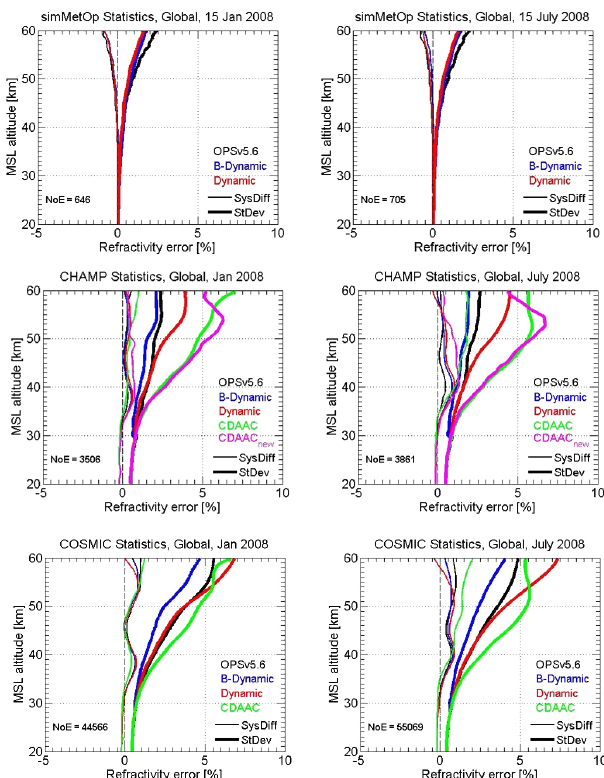
Figure 13. Systematic differences (SysDiff, light lines) and stan- dard deviations (SD, heavy lines) of retrieved refractivity profiles, relative to “perfect” simulated refractivity or co-located ECMWF analysis refractivity used as a reference, for the global ensemble of simMetOp events on 15 January and 15 July 2008 (top panels) and of CHAMP events (middle panels) and COSMIC events (bot- tom panels) from the complete months of January and July 2008. Statistics of the OPSv5.6 (black), b-dynamic (blue), dynamic (red), CDAAC (version 2009.2650 for CHAMP and version 2010.2640 for COSMIC, green), and CDAACnew (version 2014.0140 for CHAMP, magenta) statistical optimization methods are shown. The figure layout is the same as for Fig. 8.